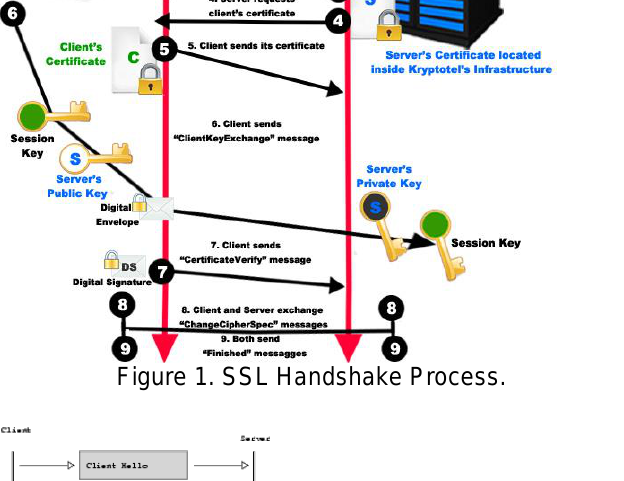
Figure 1. SSL Handshake Process.